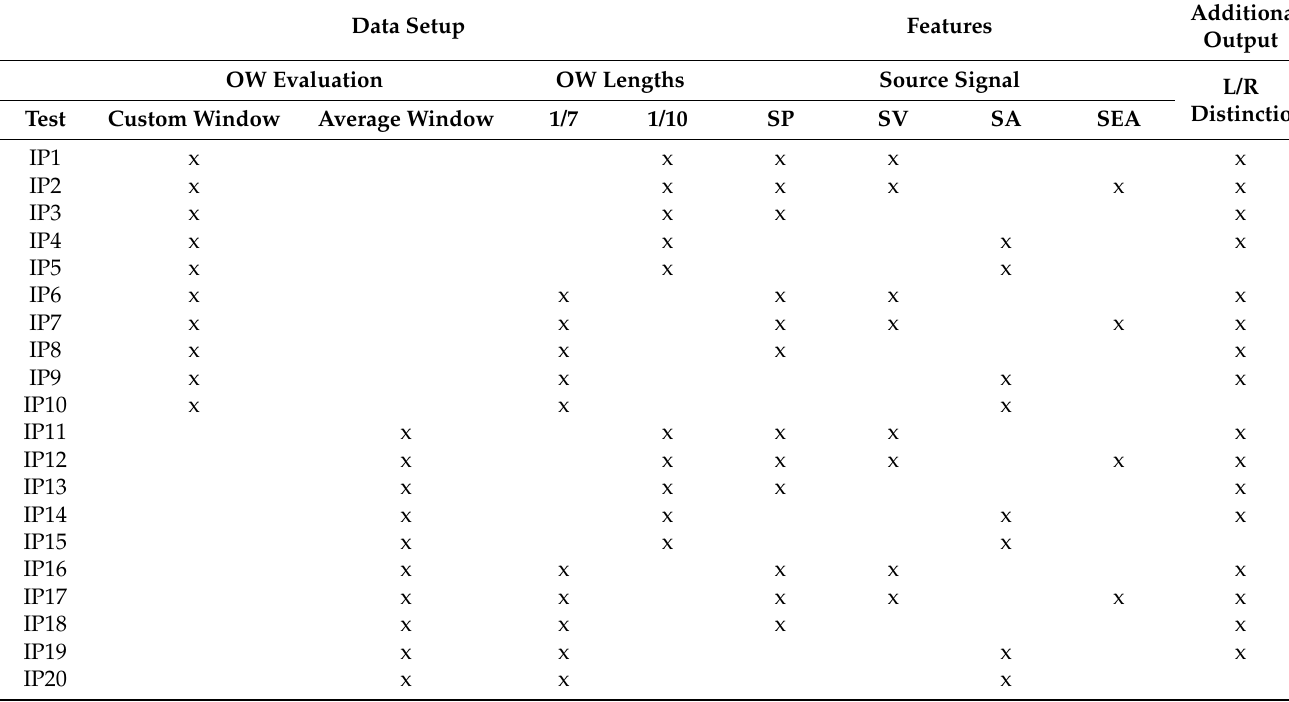
Table 1. Synthesis of the applied conditions in the tests performed for the intention prediction. In the table, source signals are described as sensor position (SP), sensor velocity (SV), sensor acceleration (SA), and sensor Euler angles (SEA); L/R indicates the left and right limb